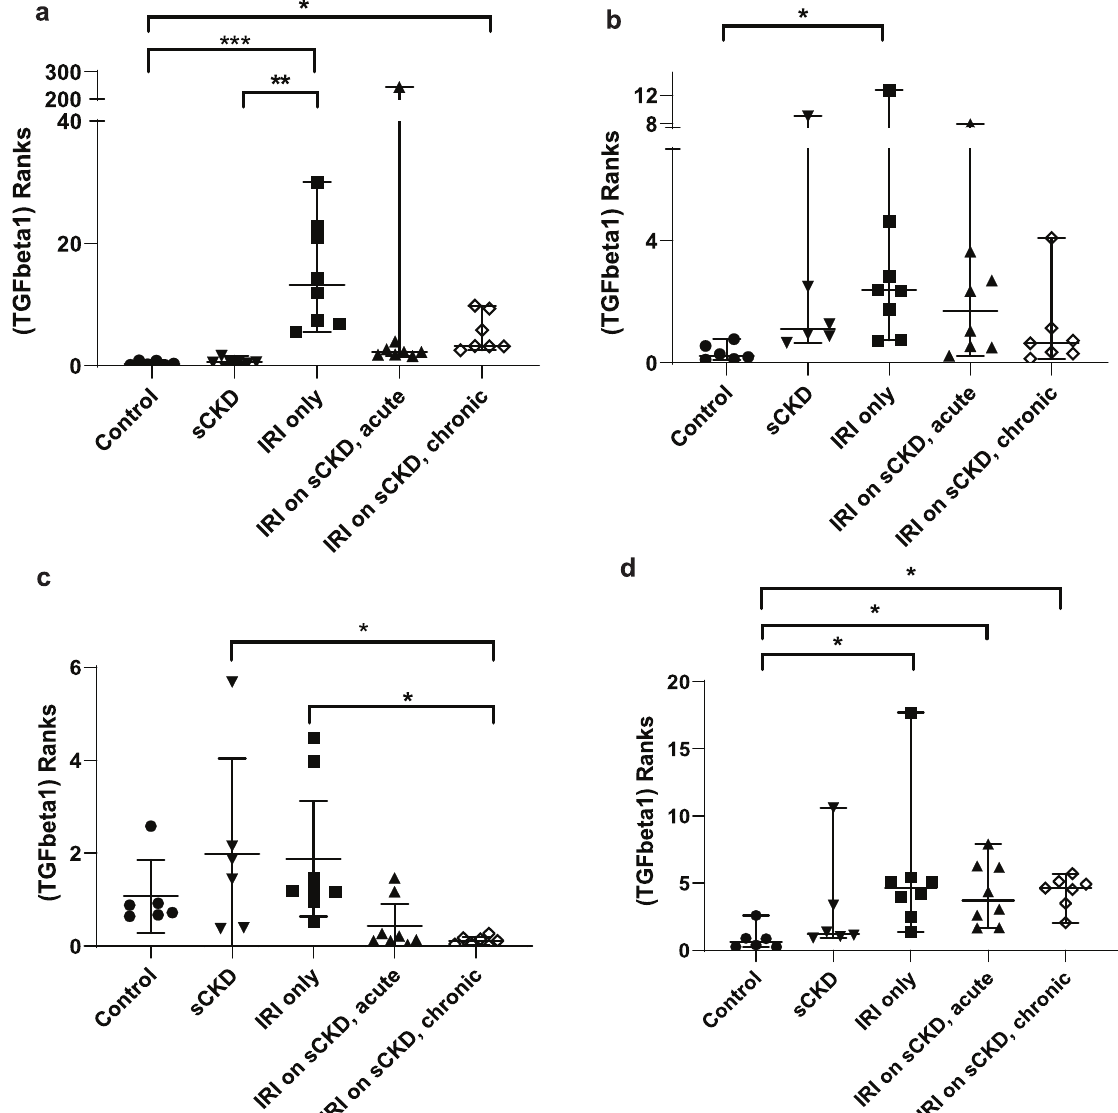
Fig 9. Rank difference between groups of TGF β 1 expression after IRI and normalised to a) 18S , b) GAPDH , c) PABPN1×HMBS , d) ACTB×PABPN1 . Data are means (one-way ANOVA) or medians (Kruskal Wallis) and 95% CI (n � 6). � p < 0.05, �� p < 0.01, ��� p <